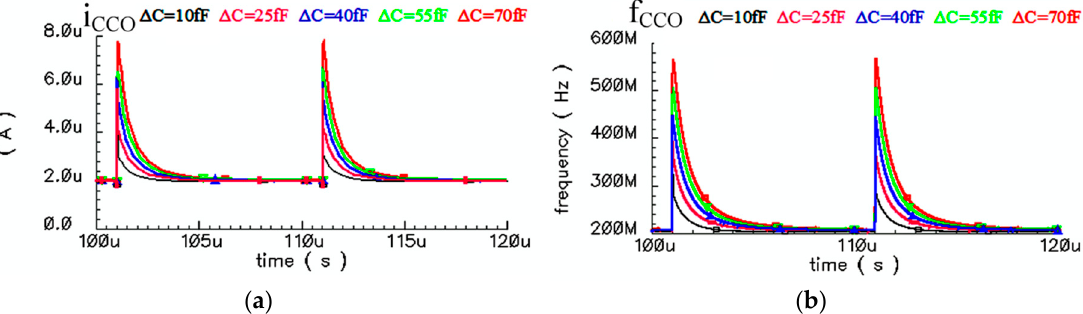
Figure 17. ( a ) Input current of the CCO, ( b ) CCO output frequency versus five different Δ Cs .